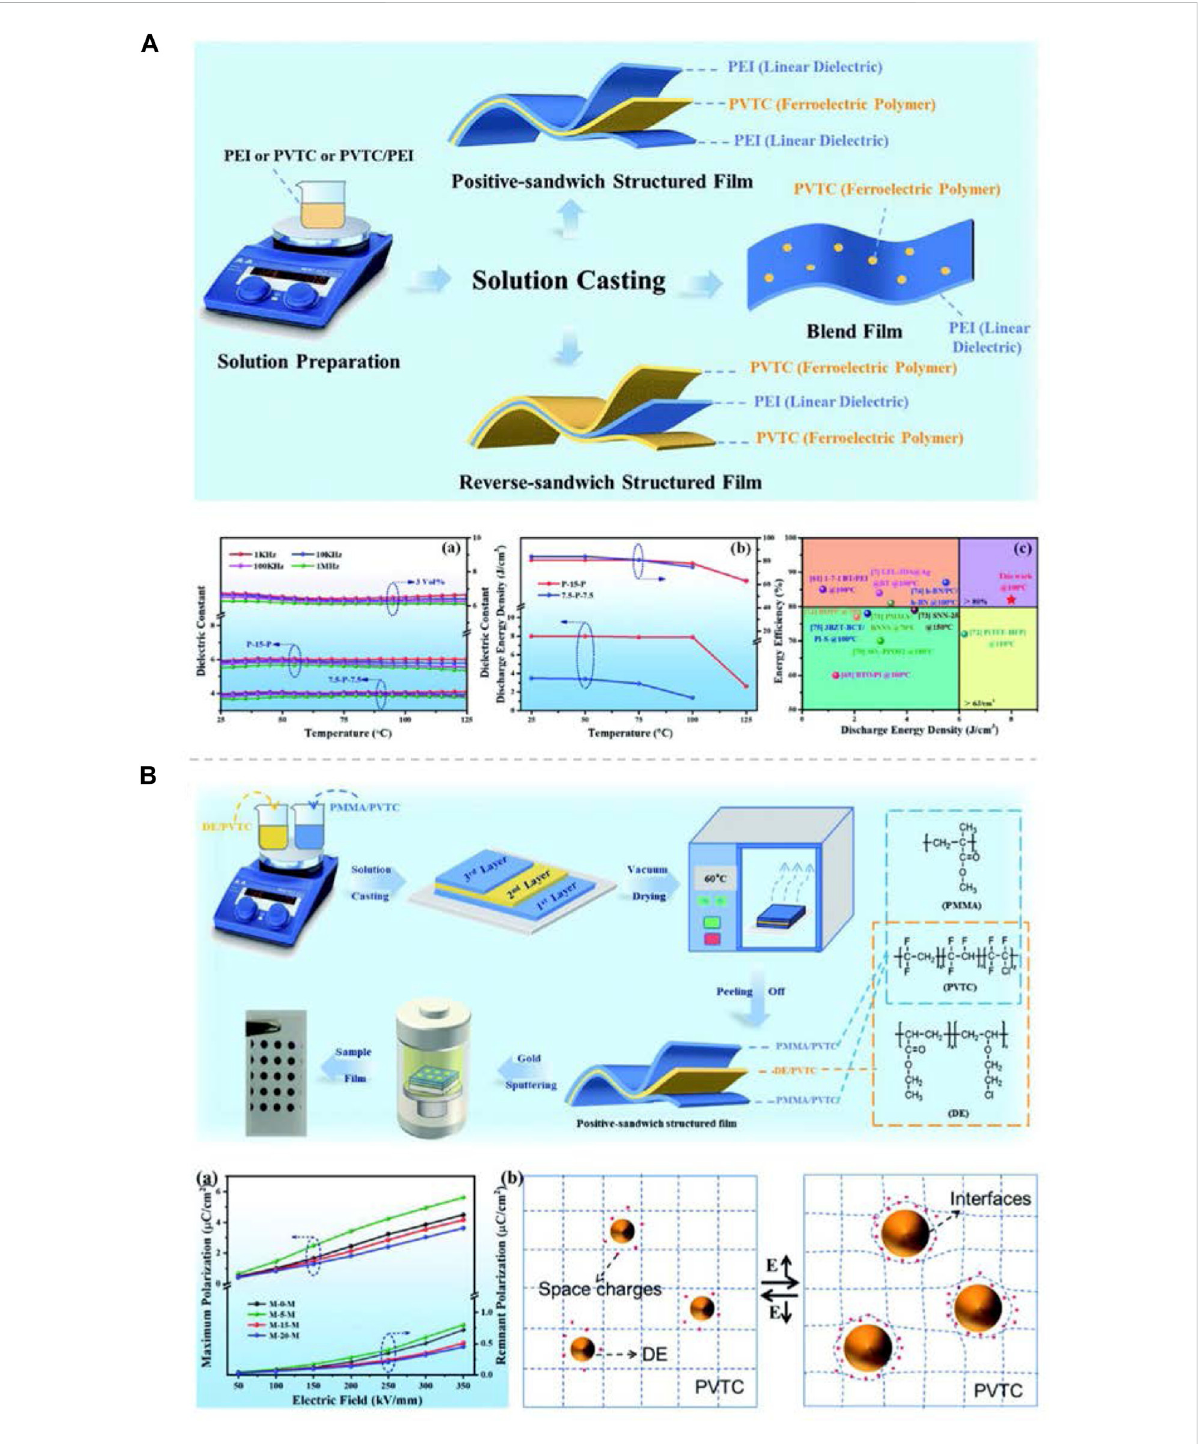
FIGURE 11 (A) Schematic of the positive-sandwich structured, reverse-sandwich structured and polymer blend fi lms fabrication process, and (a) temperature dependence of the dielectric properties of the different structures fi lm at different frequencies; (b) temperature dependence of the U e and η . (B) Flowchartshowingthepreparationofthemultilayerdielectricpolymer fi lms,and(a) D max and D r ofthepositive-sandwich-structured fi lms as a function of the electric fi eld; (b) Polarization mechanism of DE in the PVTC matrix. Reproduced with permission from Ref. 99 and 100 Copyright 2021 and 2022 The Royal Society of